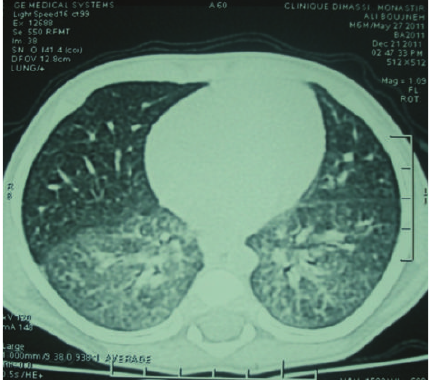
Figure 2: Chest computed tomography: bilateral interstitial infil-